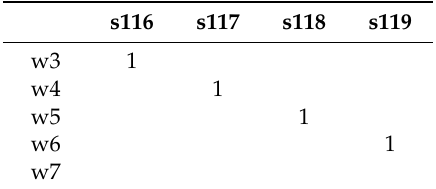
Table A19. Wind plants map w_map( w , s